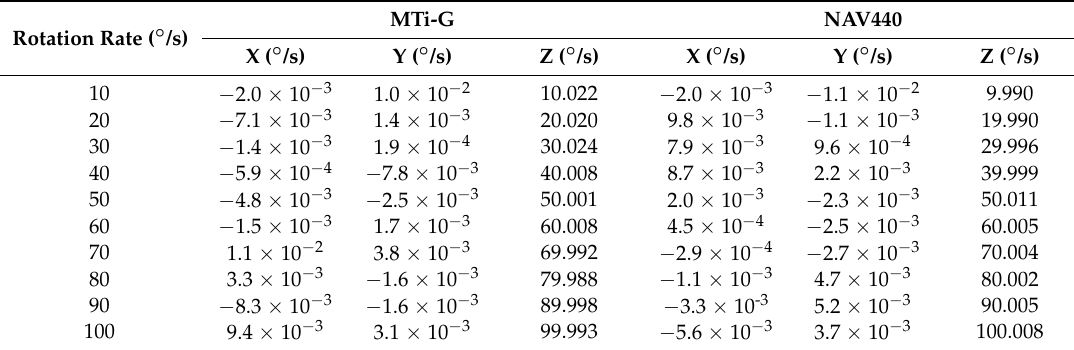
Table 7. Mean of gyro data after calibration for each individual rotary INS test.